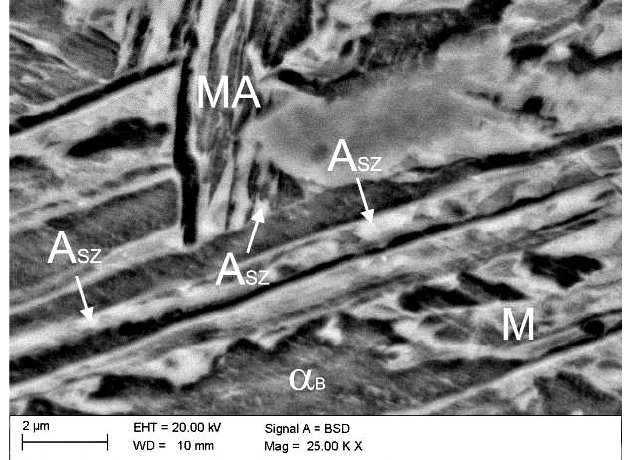
Figure 9. Microstructure of 5Mn-1.5Al steel after tensile test α B — bainitic ferrite, M — martensite, MA — martensite-austenite constituents, A SZ — retained austenite.